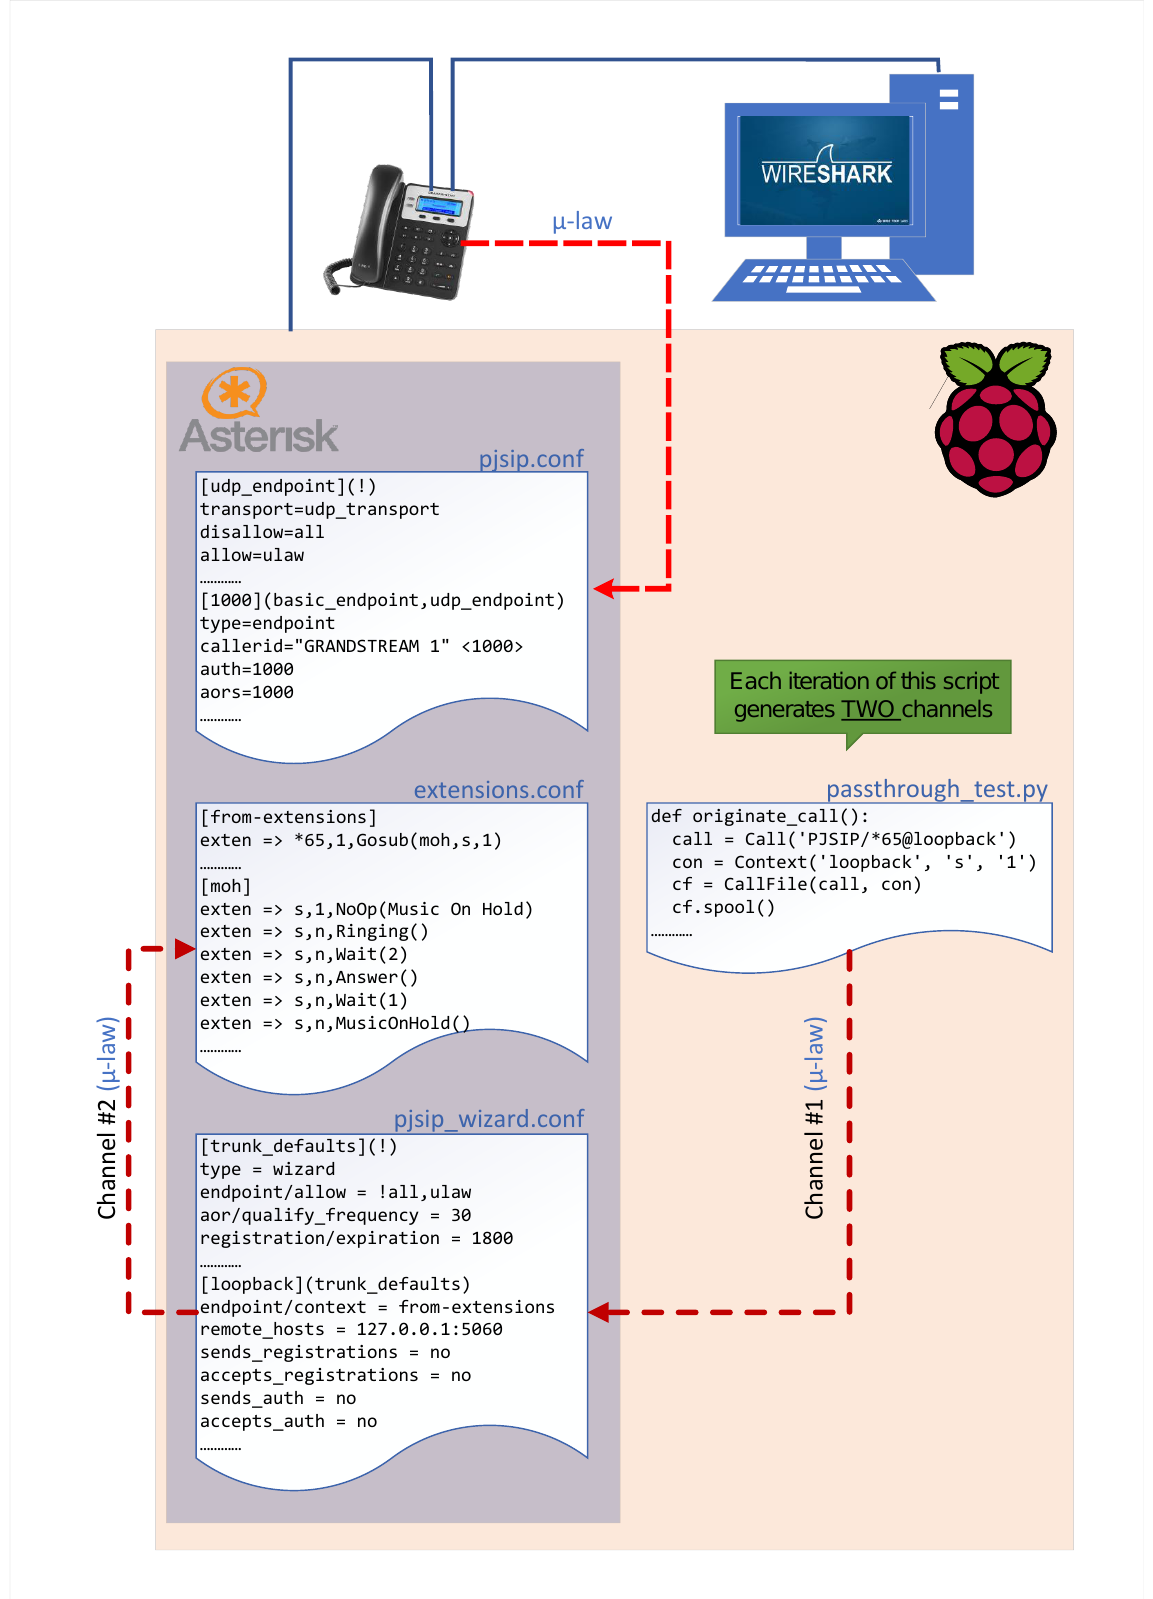
Figure 7. Passthrough VoIP testing